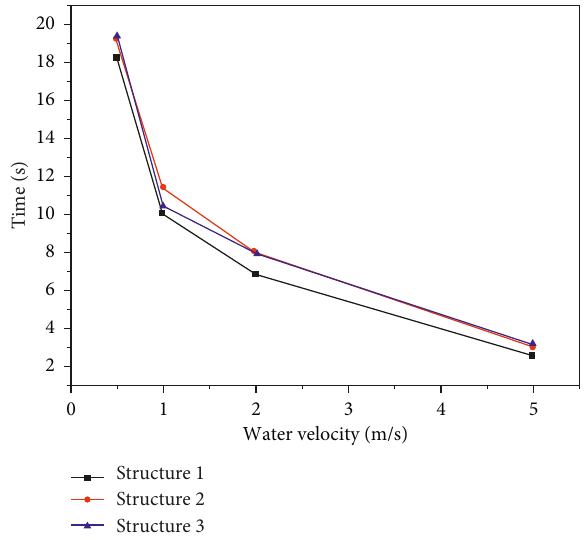
Figure 5: Relationship between the seepage time and the initial water velocity in each filling